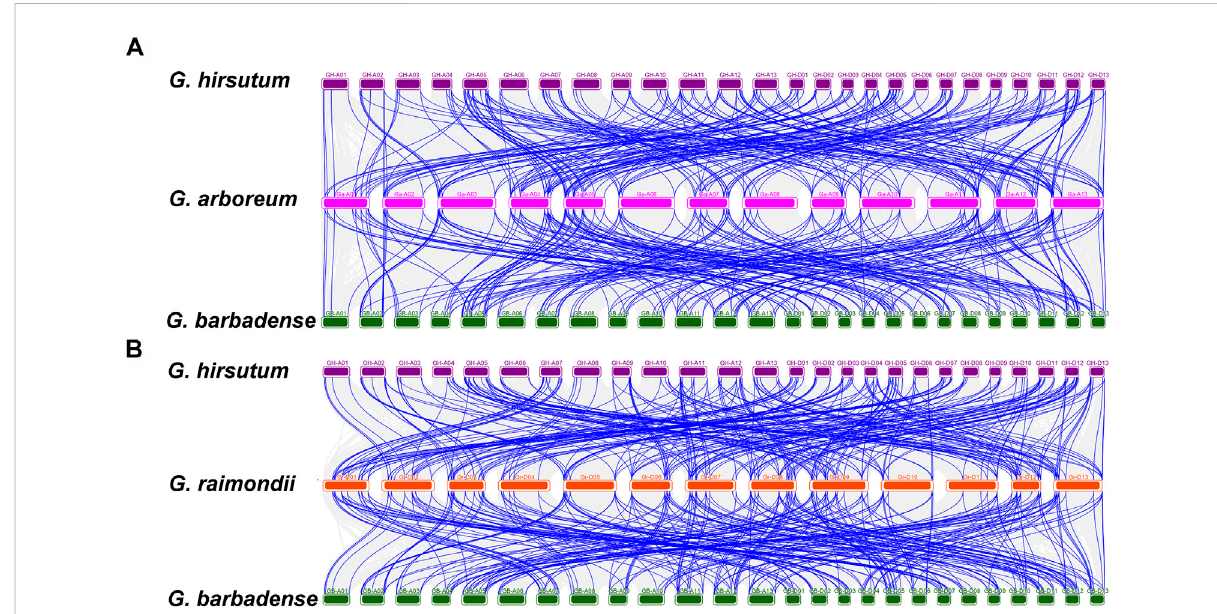
FIGURE 7 Multiple collinearity analysis of GHUGTs and GBUGTs compared with their ancestor species G. arboreum and G. raimondii . (A) Collinearity analysis of GHUGTs and GBUGTs compared with G. arboreum . (B) Collinearity analysis of GHUGTs and GBUGTs compared with G. raimondii .Dense grey lines in the background showed collinear blocks, while green lines revealed syntenic UGT gene pairs.